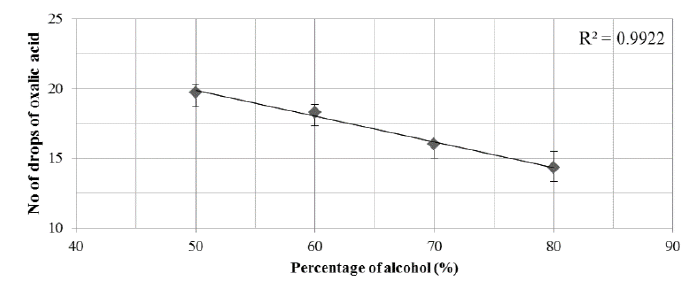
Figure 1 : Correlation of volume of oxalic acid against the percentage of alcohol in the sample. The error bars (too small to see) represent the standard deviation of the volume for n=3.